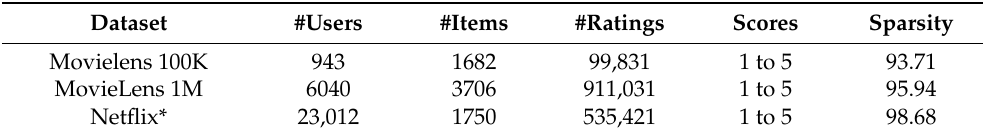
Table 1. Values of the main parameters of the tested datasets. Dataset